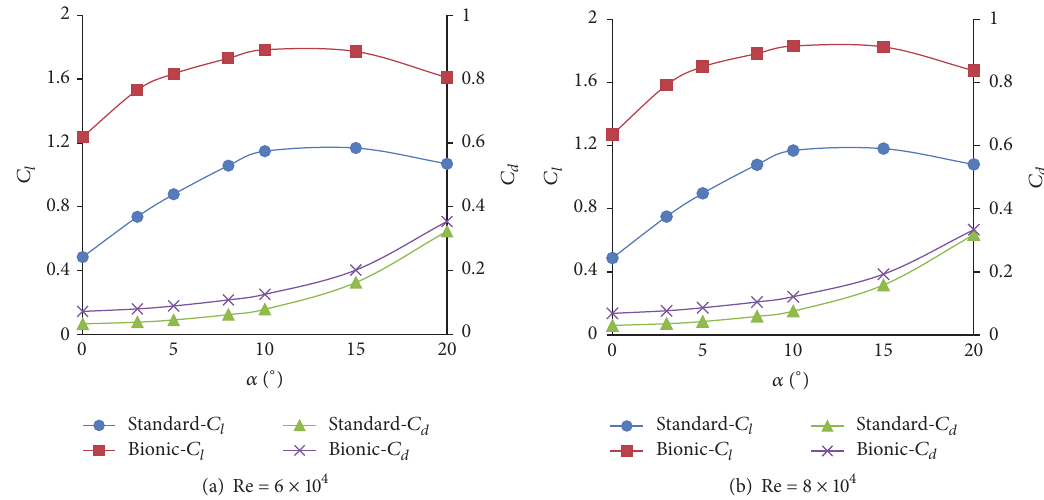
Figure 15: Lift coefficients ( 𝐶 𝑙 ) and drag coefficients ( 𝐶 𝑑 ) of the airfoils at different AOA. “Standard- 𝐶 𝑙 ” is the lift coefficient of the standard airfoil, and “Standard- 𝐶 𝑑 ” is the drag coefficient of the standard airfoil. “Bionic- 𝐶 𝑙 ” is the lift coefficient of the bionic airfoil, and “Bionic- 𝐶 𝑑 ” is the drag coefficient of the bionic